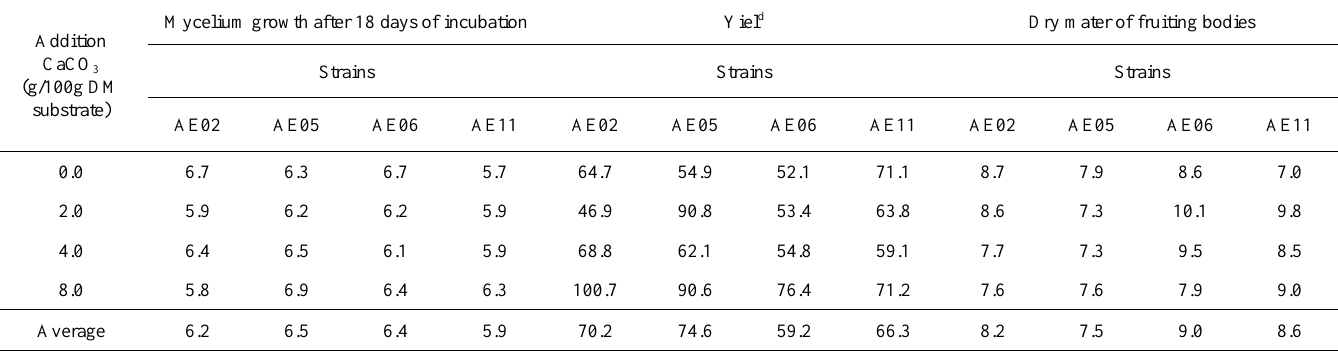
Table 1. Influence of addition of CaCO 3 on mycelium growth (after 18 days of incubation) [cm], yield [g/100g] and dry matter of fruiting bodies [%]